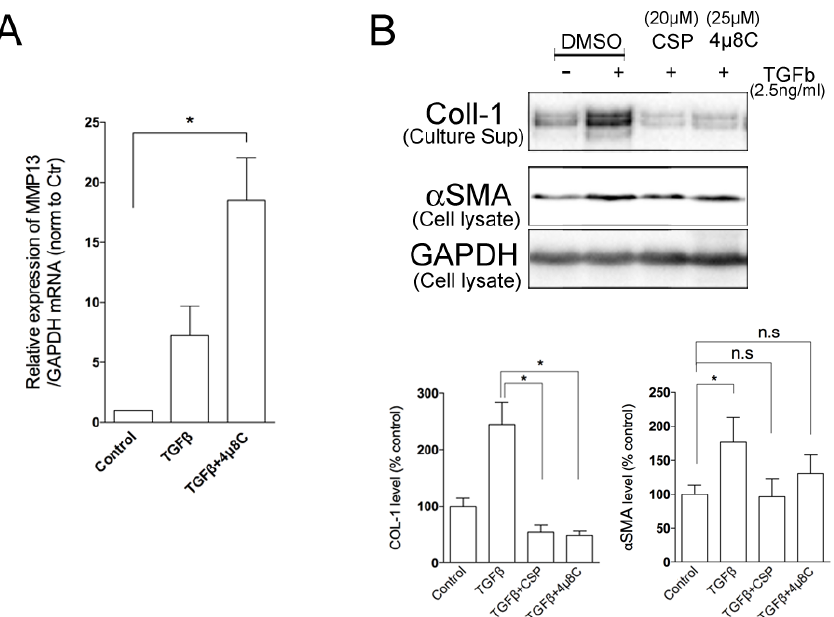
Figure 6. Effects of IRE1 α inhibitor on MMP13 and Collagen 1 secretions. TGF β -stimulated human IPF LFs were treated either with or without 4 µ 8C (25 µ M). ( A ) IRE1 α inhibitor enhanced the expres- sion of MMP13 in hIPF-Lfs. cDNA synthesized from total RNA in each condition was subjected to qPCR to determine gene expression level of MMP13. Values are means ± SEM from three inde- pendent experiments. GAPDH mRNA levels were used as an internal control to normalize gene expression. p * values by one-way ANOVA with the Dunnett’s multiple comparisons test ( p < 0.05). ( B ) An IRE1 α inhibitor, 4µ8C, reduced the secretion of collagen 1 from human IPF LFs. Culture supernatants and whole cell lysates were subjected to Western blotting for collagen 1 (COL-1). Upper panel: Representative Western blot images. Lower Panels: Statistical representation of the Western blot analysis. Values are means ± SEM from three independent experiments. GAPDH was used as an internal control to normalize protein expression. p * values by one-way ANOVA with the Dunnett’s multiple comparisons test ( p < 0.05).